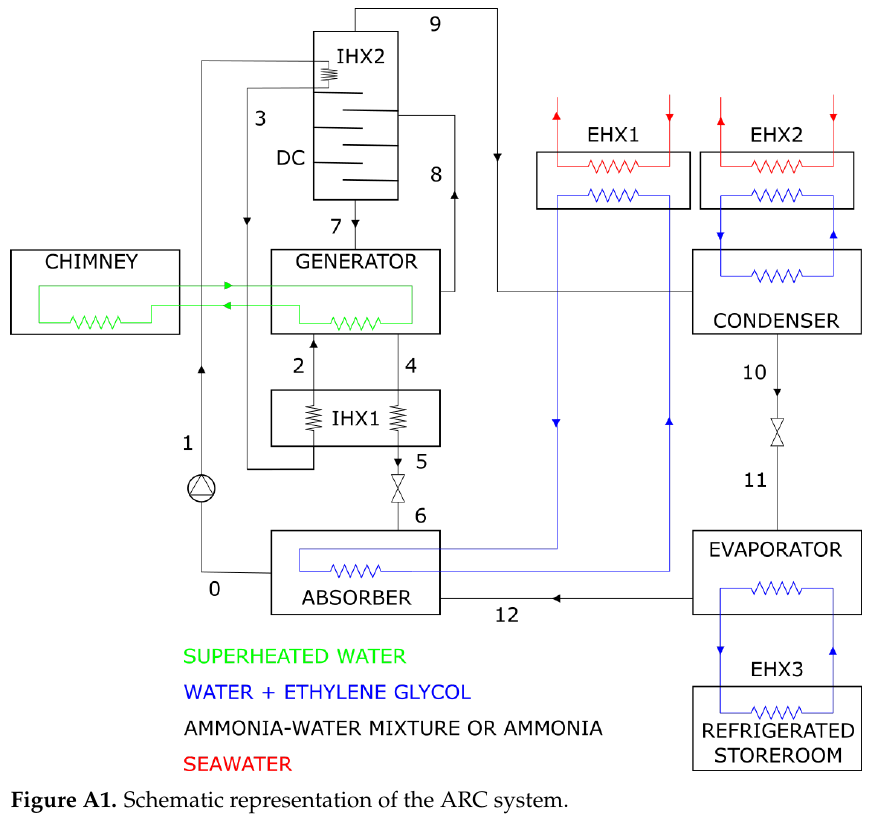
Figure A1. Schematic representation of the ARC